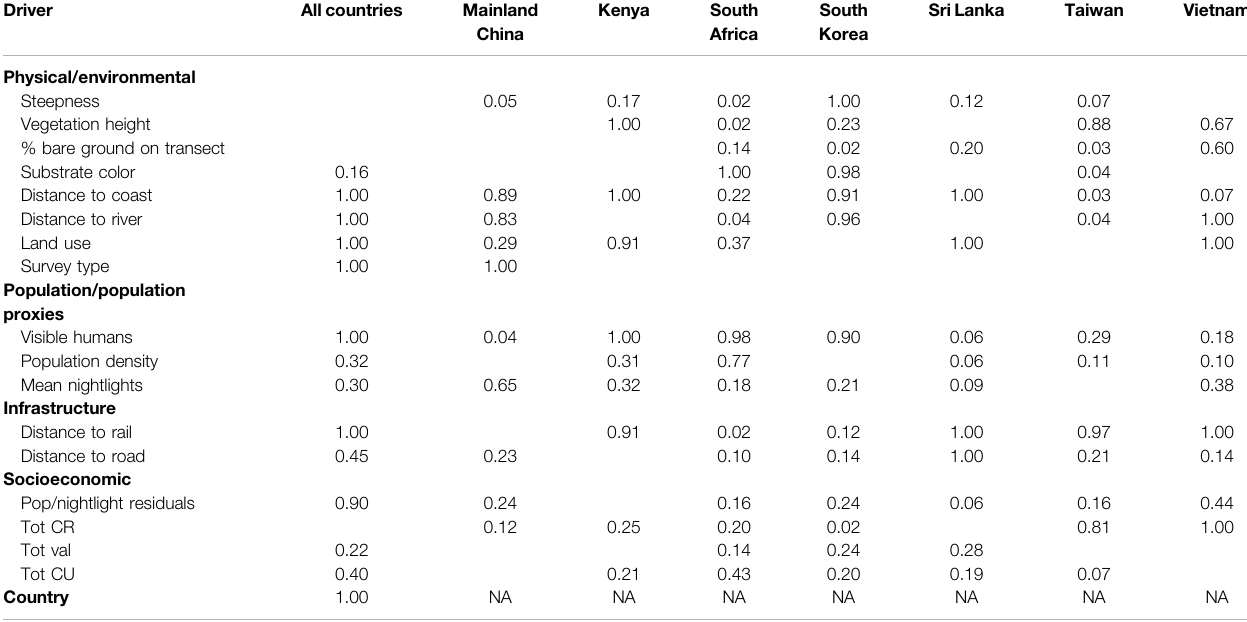
TABLE 4 | Variable importance scores. Blank cells indicate that the driver was not present in the top models. Importance scores are calculated as the proportion of the models within the model averaging in which the driver appears.